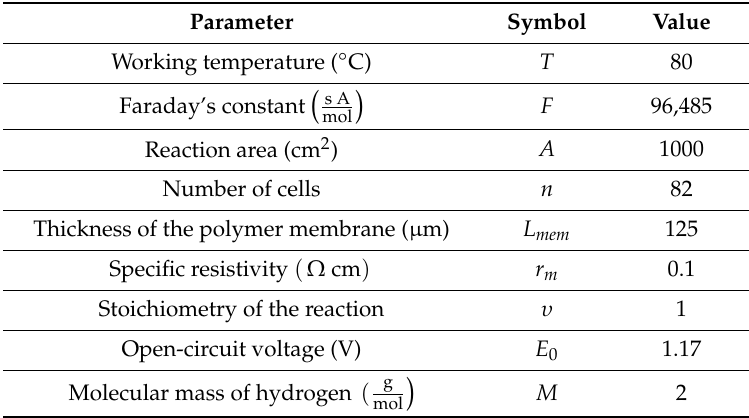
Table 3. Main input data used in the fuel cell simulation [31].